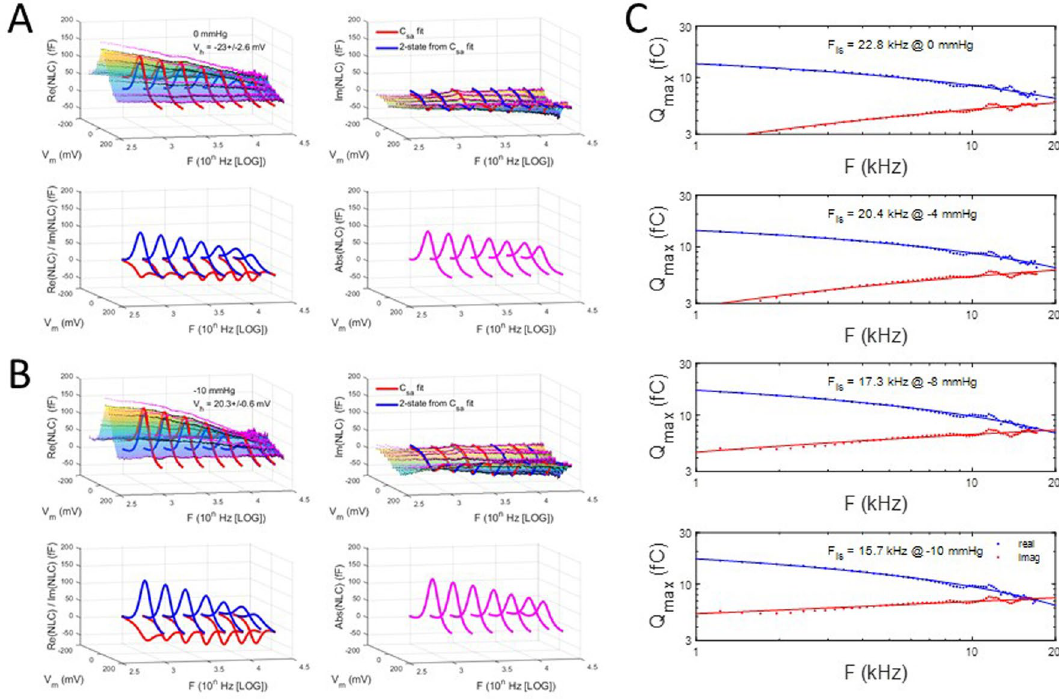
Figure 10. Membrane tension effects on the frequency response of complex capacitance for positive initial V h . (A) 0 mmHg, (B) − 10 mmHg. Clear changes, especially in the imaginary component, are noted between the two tensions. These changes are highlighted in (C) where the intersection frequency, F is , is found to decrease with increases in tension. A shift from 22.1 to 16.8 kHz occurs between the two